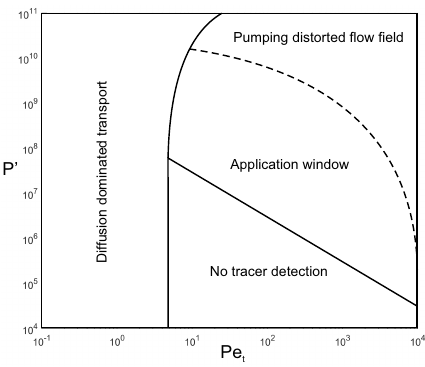
Figure 10. The proposed application window of the thermal tracer tomography – related to the injection parameters of the thermal tracer test (effective injection power P (cid:48) ) – and the dominant trans- port process of the aquifer zone (thermal Péclet number Pe t ). If Pe t is below a critical value, the heat transport is diffusion-dominated, and no hydraulic information can be inverted from the tracer travel times. At low injection power, the temperature change at the obser- vation points is below 0.1 ◦ C and no detection is possible. At very high P (cid:48) the high injection rate distorts the flow field and the results. The application window can help to find the ideal injection param- eters based on the prior knowledge about the investigated aquifer.